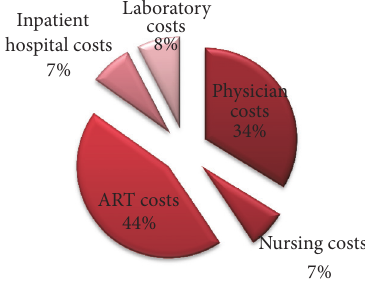
Figure 1: Disaggregated costs for the ARV cohort.